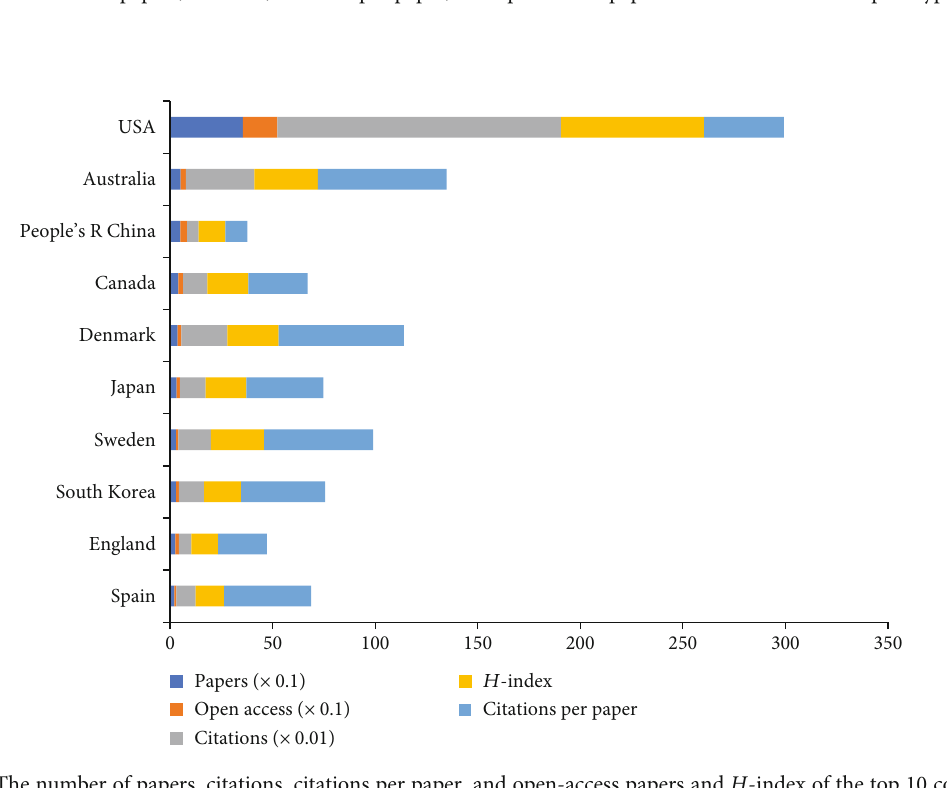
Figure 5: The number of papers, citations, citations per paper, and open-access papers and H -index of the top 10 types of pain.